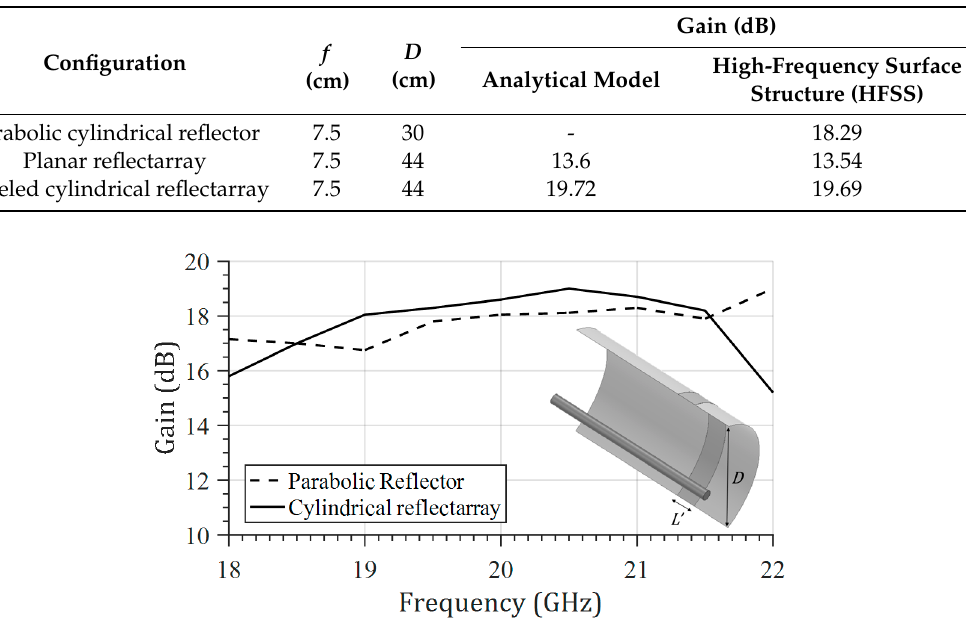
Figure 3. Comparison of the simulated gain performance for a L (cid:48) × D portion of the classical parabolic reflector (dotted line) and of the segmented reflectarray (continuous line). L (cid:48) = 5 mm, D = 30 cm for the cylindrical parabolic reflector and D = 44 mm for the cylindrical reflectarray.